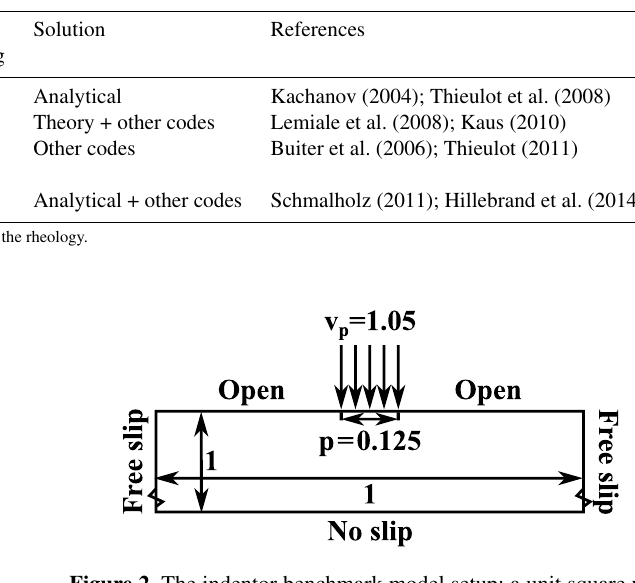
Figure 2. The indentor benchmark model setup: a unit square with free-slip vertical and no-slip lower boundaries. The punch area has a prescribed vertical velocity v p ; the rest of the upper boundary is